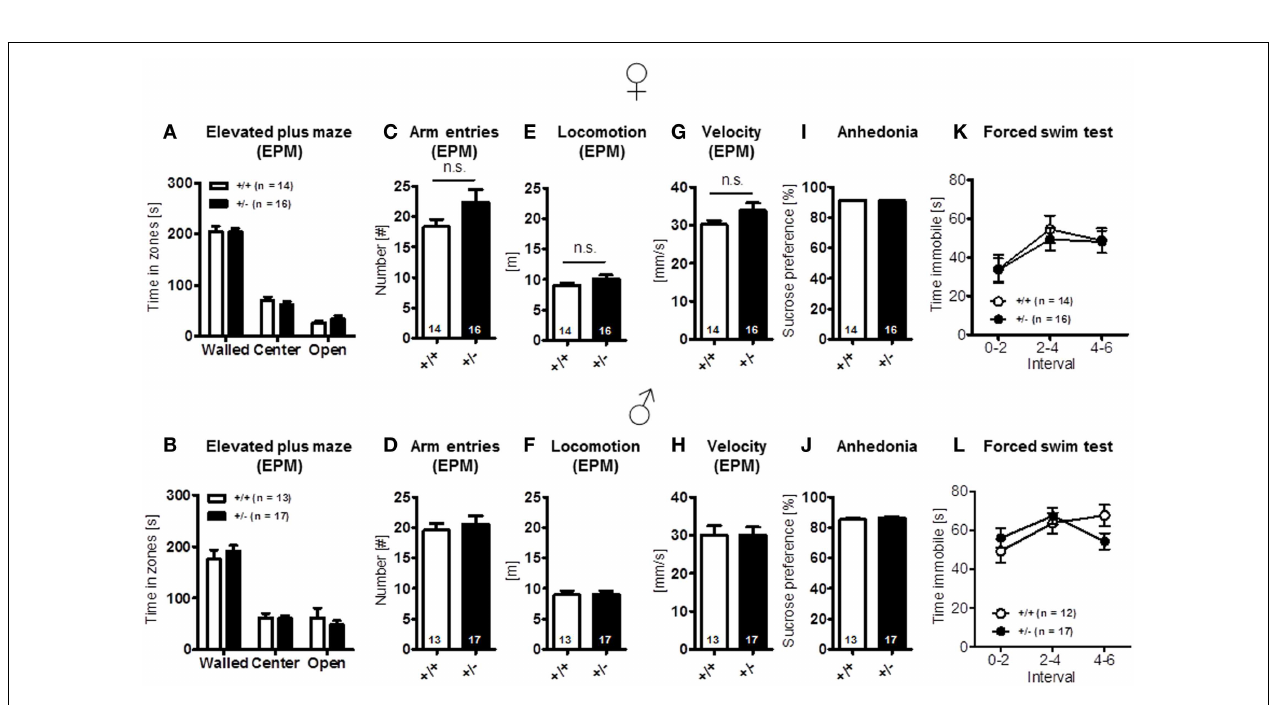
(C,D) motor performance and motor learning; (E,F) startle response to a 120db stimulus; and (G,H) pre-pulse inhibition. Mean ± SEM presented; respective sample sizes are indicated in the figures.